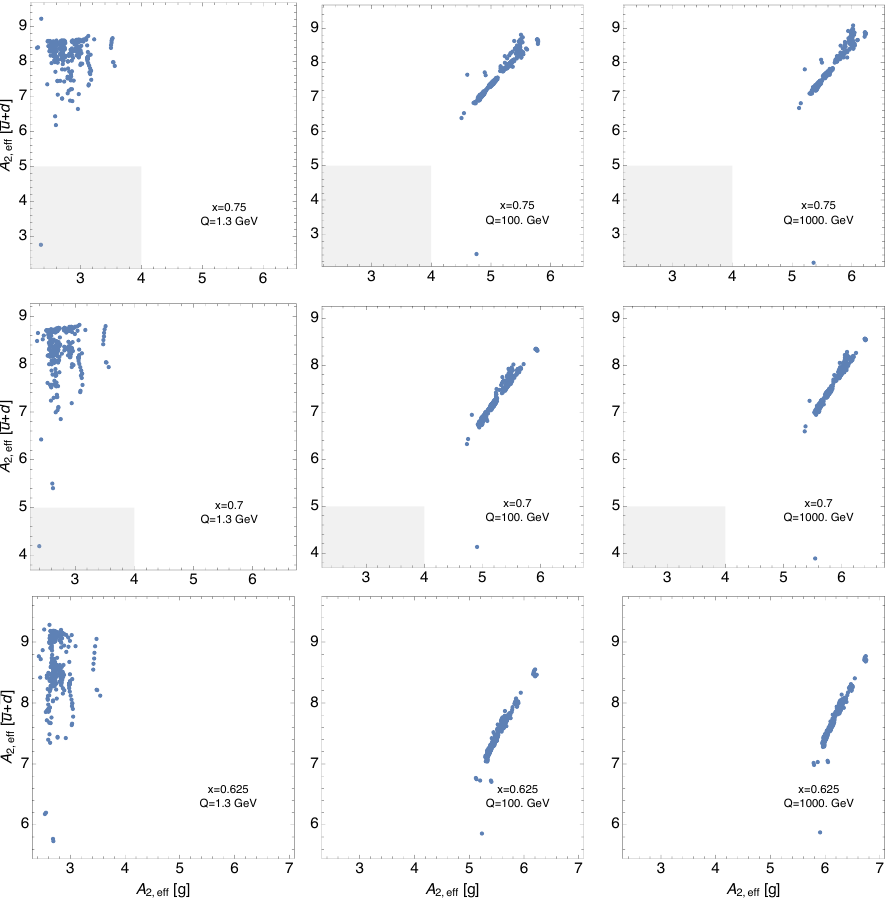
Figure 3: A eff for the gluon against ¯ u + ¯ d , for various x values. The Q values, from left 2 to right, 1.3, 100, and 1000 GeV. The shaded area corresponds to regions unfavored by quark counting